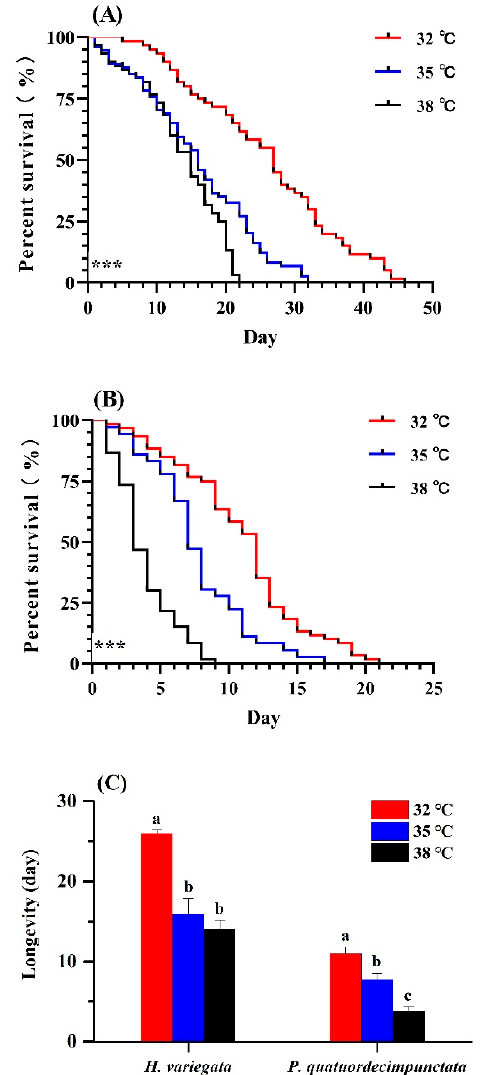
Figure 1. Survival curves of adult Hippodamia variegata ( A ) and Propylaea quatuordecimpunctata ( B ) at different temperatures. ( C ) Adult longevity of both species. Survival statistics were calculated using the Kaplan–Meier survival curve and compared using the log-rank test (individuals = 60, *** p < 0.001). For each species, different letters above the bars indicate statistically significant differences (ANOVA; Tukey’s post hoc test; p < 0.05).